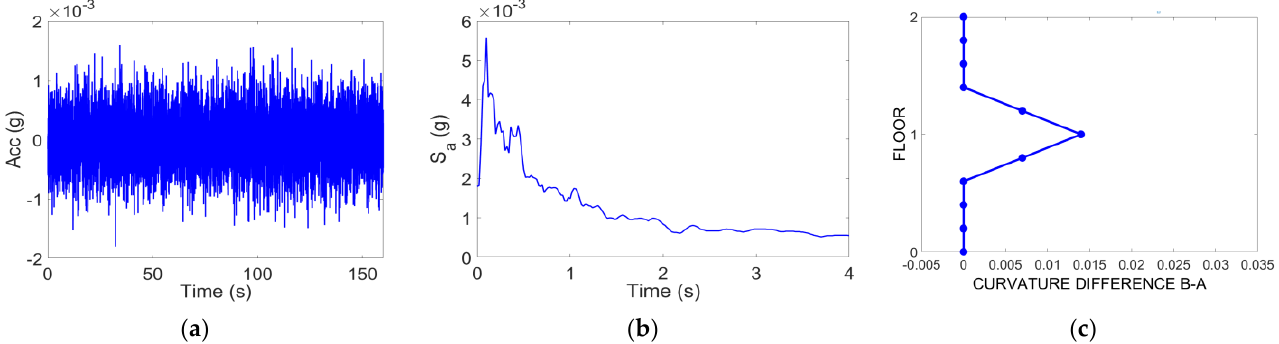
Figure 23. Results for the event that occurred on 9 April 2009 at 02:34: ( a ) ground accelerometric recordings; ( b ) response spectrum; ( c ) curvature differences between the selected time-instants B and A.